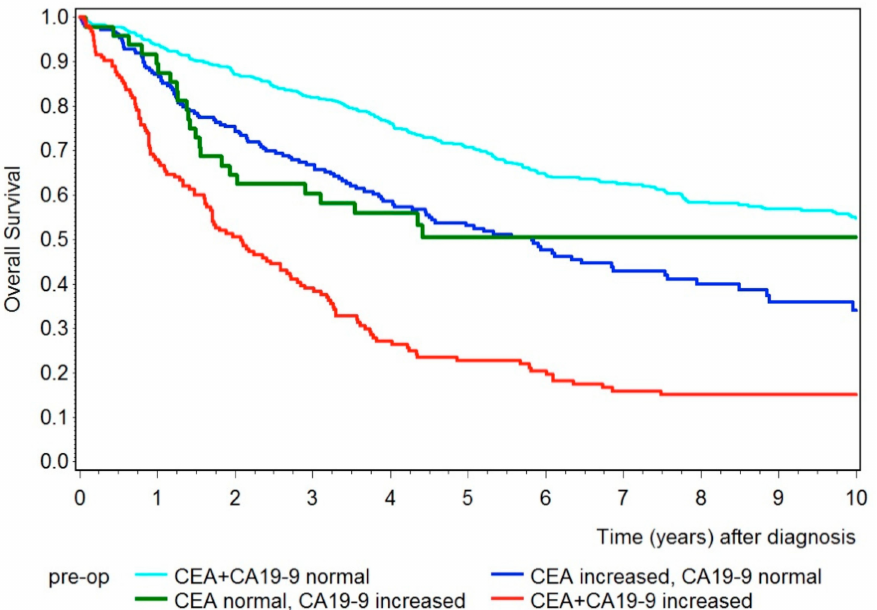
Figure 4. Kaplan–Meier curves showing overall survival for patients with both preoperative tumor markers below the cut-off value (turquois), with only CEA increased (blue), with only CA19-9 increased (green), and with both tumor markers increased